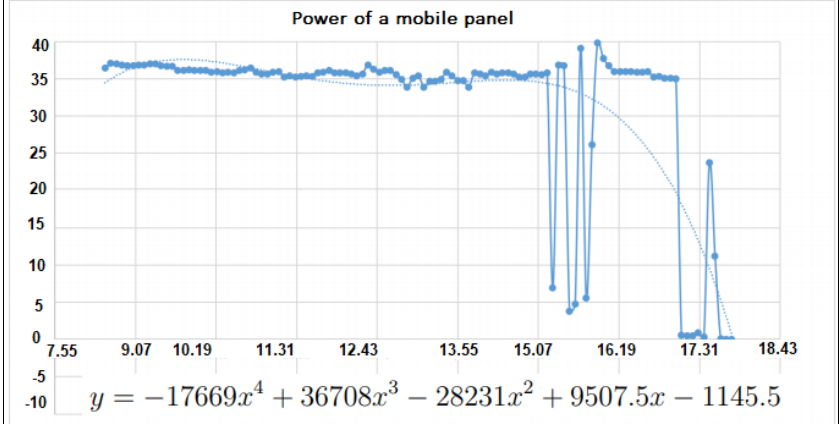
Figure 17: Graph of generated power, day one mobile